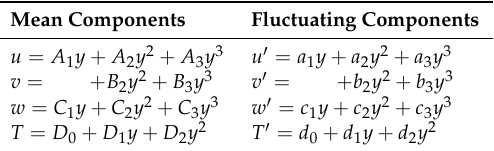
Table 2. Expansion for the components of the velocity and temperature for plane coordinates x - z around wall points and y distance from the